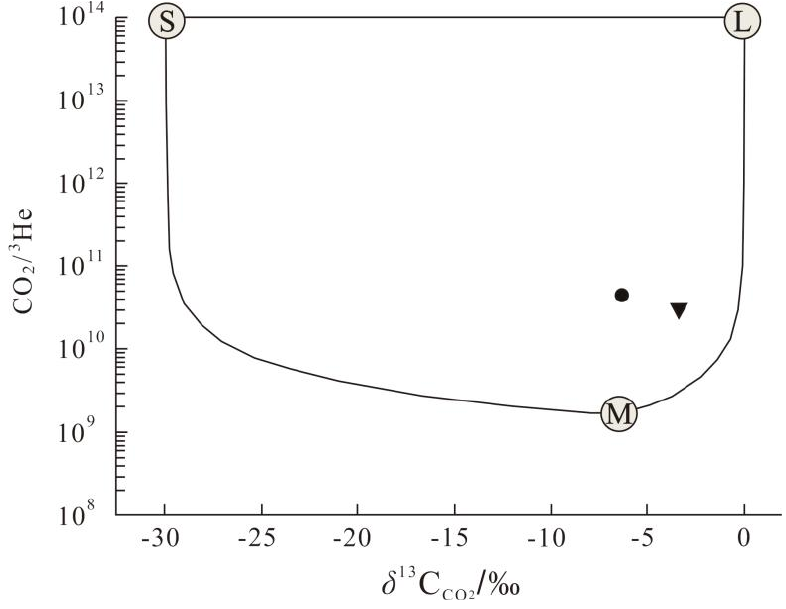
Figure 8. A plot of CO 2 / 3 He values vs. δ 13 C CO2 values obtained for the hot spring gases. The CO 2 sources of the hot spring gas were divided into three main source end elements—mantle carbon (M): CO 2 / 3 He = 2 × 10 9 , δ 13C = − 6.5‰; limestone (L): CO 2 / 3 He = 1 × 10 13 , δ 13C = 0‰; and sedimentary organic carbon (S): CO 2 / 3 He = 1 × 10 13 , δ 13C = − 6.5‰ [88,89]. Table 4. The CO 2 gas from mantle, limestone, and sedimentary sources in the hot spring gases of the study region. Sampling Springs Mantle Carbon (M) Limestone (L) Sedimentary Organic Carbon (S) YTBLK